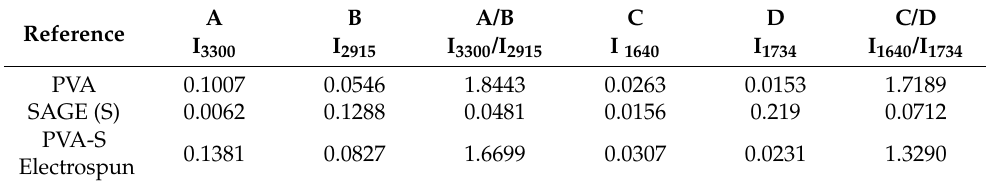
Table 6. Band intensity of FTIR spectra of PVA, sage, and electrospun PVA − sage nanofiber veils. Reference